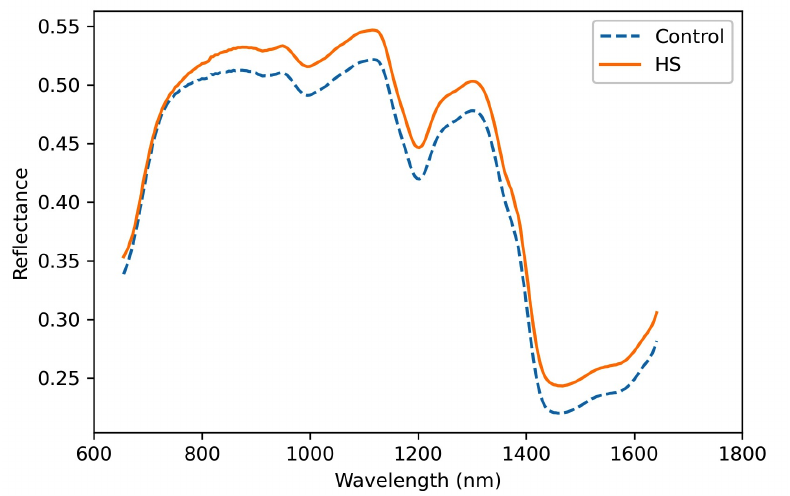
Figure 7. The averaged spectral curves of seeds in control and HS groups ( n = 100 seeds for each